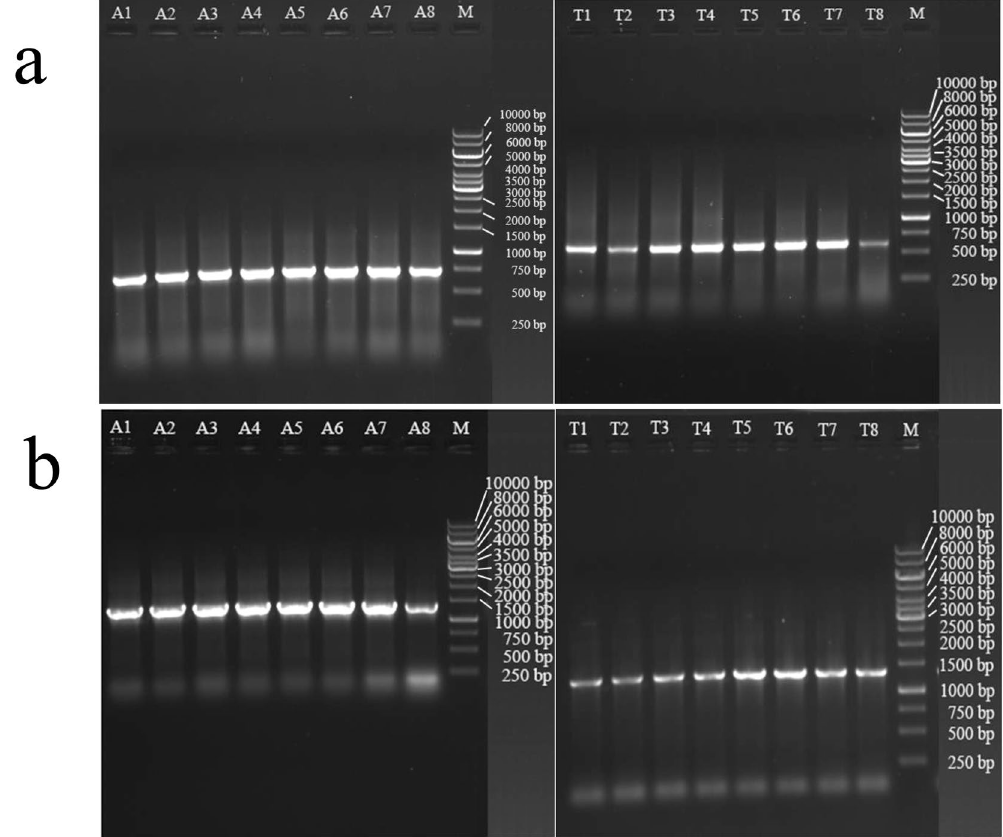
Figure 3. A representative gel of PCR products of ITS ( a ) and a single-copy gene ( b ) from mushroom specimens dried using different methods and stored for one month. A, Agaricus bisporus , A1: Silica gel at 22 °C; A2: Oven at 22 °C; A3: Oven at 38 °C; A4: Oven at 50 °C; A5: Oven at 60 °C; A6: Oven at 70 °C; A7: Oven at 80 °C; A8: Oven at 93 °C; M: GeneRuler 1 kb DNA ladder; T, Trametes versicolor , T1: Silica gel at 22 °C; T2: Oven at 22 °C; T3: Oven at 38 °C; T4: Oven at 50 °C; T5: Oven at 60 °C; T6: Oven at 70 °C; T7: Oven at 80 °C; T8: Oven at 93 °C; M: GeneRuler 1 kb DNA